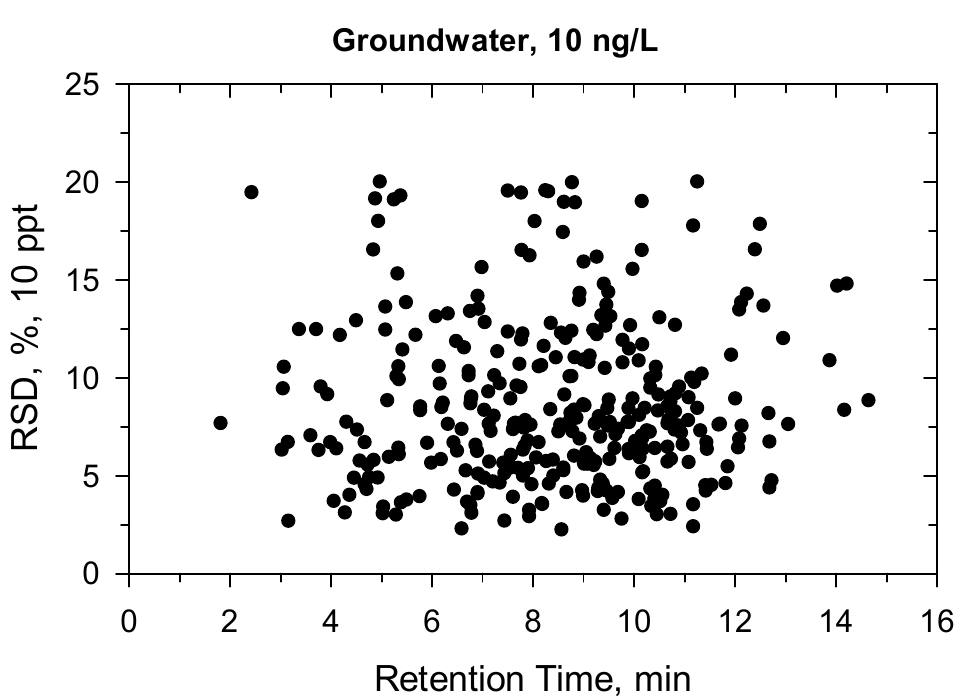
Figure 1. Recovery (%) versus retention time (min) at 10 ng/L in groundwater.